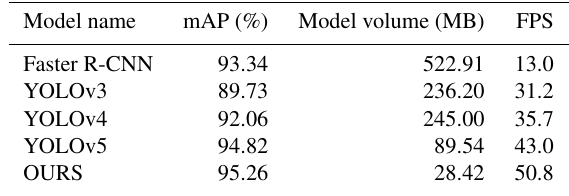
Table 4. Performance comparison of different